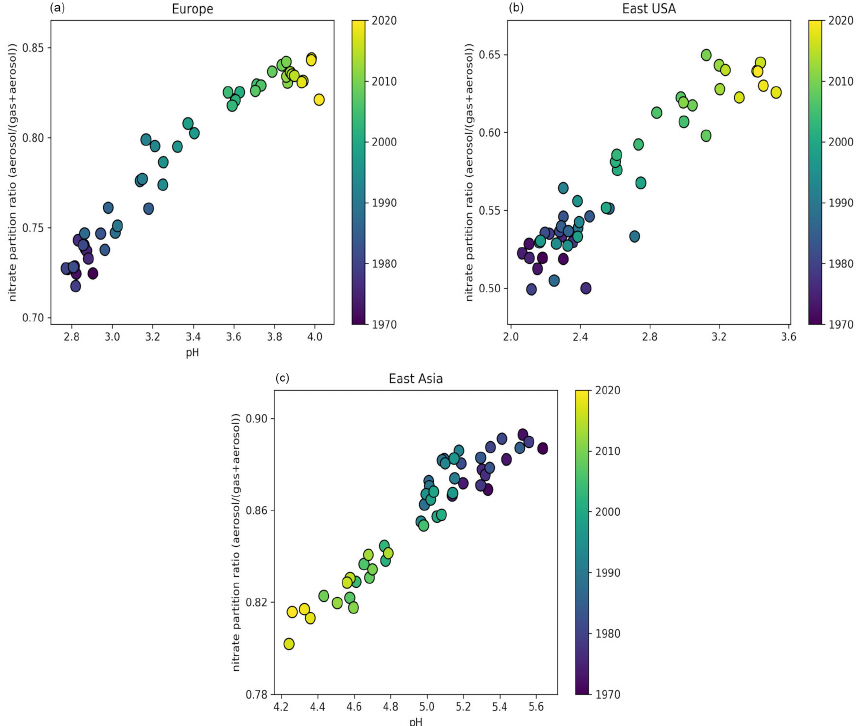
Figure 3. Time evolution of particle-phase fraction of total nitrate as a function of pH over Europe (a) , the eastern USA (b) , and East Asia (c) during the period